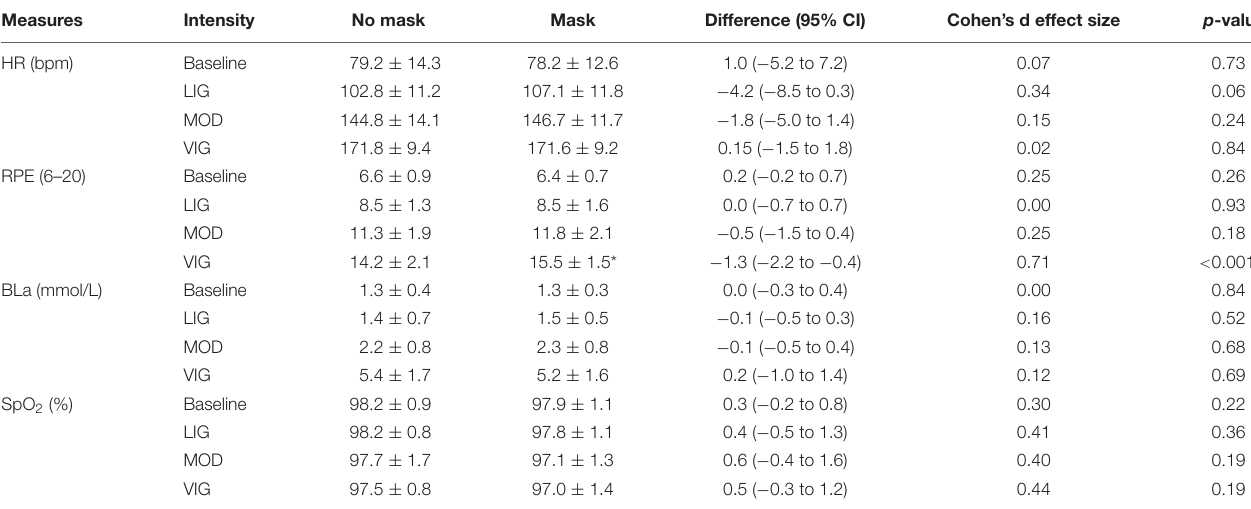
TABLE 2 | Mean physiological responses and perceived exertion.